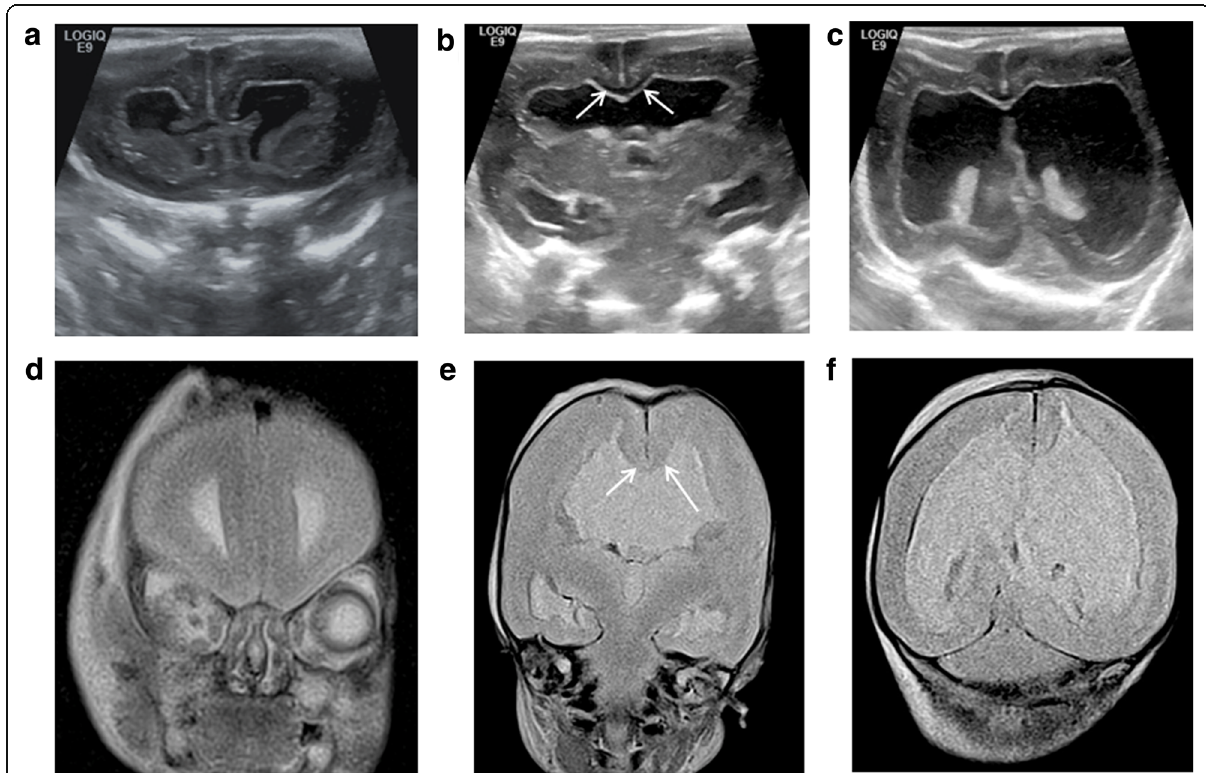
Fig. 3 Post-mortem ultrasound images of the brain, in coronal section (top row), with matched T2-weighted post-mortem MRI images (bottom row) performed on the same day, in a foetus at 21 weeks gestation, 9 days after death. These have been obtained through the frontal lobe ( a , d ), at the level of the Foramen of Monro ( b , e ) and through the posterior horns of the lateral ventricles ( c , f ). The pregnancy was terminated for suspected foetal ventriculomegaly and an absent corpus callosum. From the post-mortem ultrasound, the ventriculomegaly was well depicted before the MRI was performed, and a corpus callosum was in fact present (white